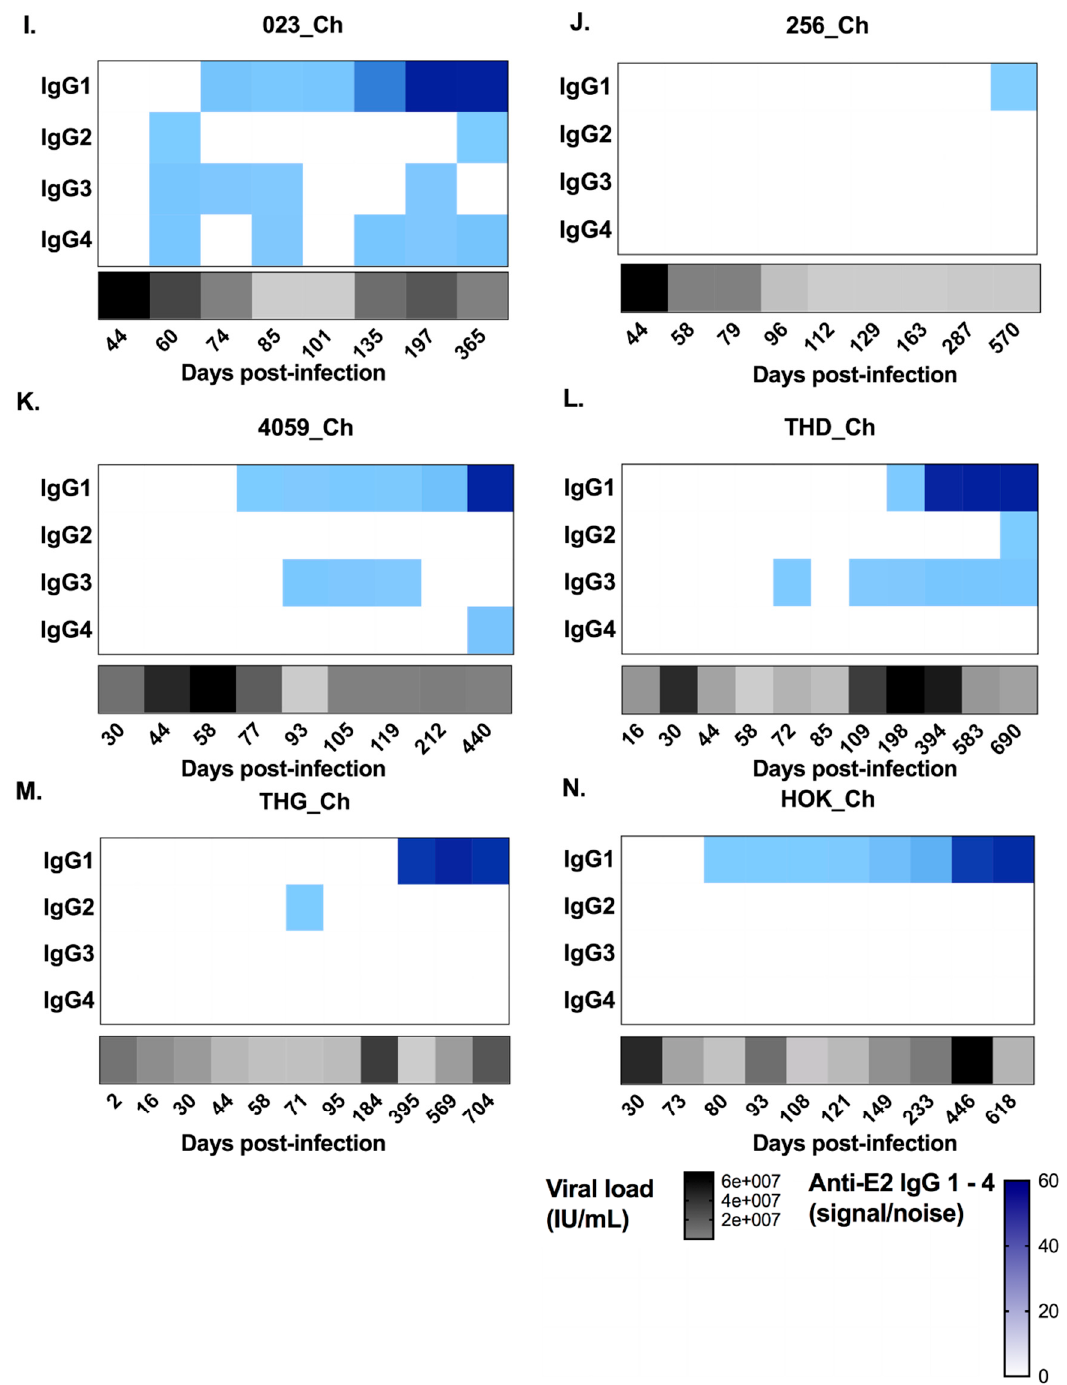
Figure 4. Heat maps representing longitudinal patterns of anti-HCV E2-antibody subclass utilisation (signal / noise) for IgG1–4 responses, as well as HCV RNA levels (IU / mL), in clearer and chronic progressor subjects. Panels A – G show subjects who cleared the infection. Panels H – N show subjects who developed chronic hepatitis. Anti-E2 IgG1–4 (signal / noise) is represented in blue with lower magnitudes in lighter blue and higher magnitudes in darker blue (see key). HCV RNA levels (IU / mL) are represented in grey / black (see key). Days post infection are indicated below each heat map. All results were generated from duplicate measures from all serum samples collected for each subject.